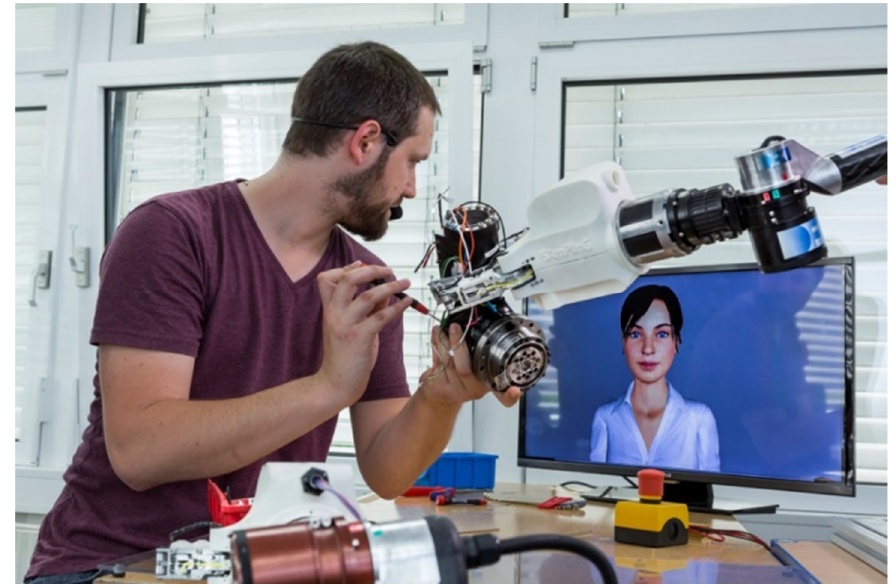
Figure 1. A Cobot and a Softbot helping a human worker (Source: